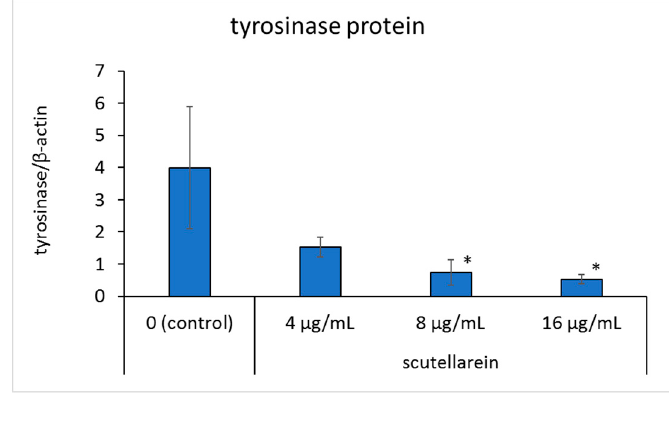
7 of 12 Figure 5. The effects of the tested compounds on mushroom tyrosinase activity. Mushroom tyrosi- nase activity was determined by calculating the absorbance change rate in 10 min at 475 nm. 4-n- butylresorcinol: 40 μ mol/L (6.64 μ g/mL), 20 μ mol/L (3.32 μ g/mL), 10 μ mol/L (1.66 μ g/mL), 5 μ mol/L (0.83 μ g/mL), 2.5 μ mol/L (0.42 μ g/mL), 1.25 μ mol/L (0.21 μ g/mL), 0.625 μ mol/L (0.10 μ g/mL). scutellarein: 40 μ mol/L (11.44 μ g/mL), 20 μ mol/L (5.72 μ g/mL), 10 μ mol/L (2.86 μ g/mL), 5 μ mol/L (1.43 μ g/mL), 2.5 μ mol/L (0.72 μ g/mL), 1.25 μ mol/L (0.36 μ g/mL), 0.625 μ mol/L (0.18 μ g/mL). baicalein: 40 μ mol/L (10.8 μ g/mL), 20 μ mol/L (5. 4 μ g/mL), 10 μ mol/L (2.7 μ g/mL), 5 μ mol/L (1.35 μ g/mL), 2.5 μ mol/L (0.68 μ g/mL), 1.25 μ mol/L (0.34 μ g/mL), 0.625 μ mol/L (0.17 To